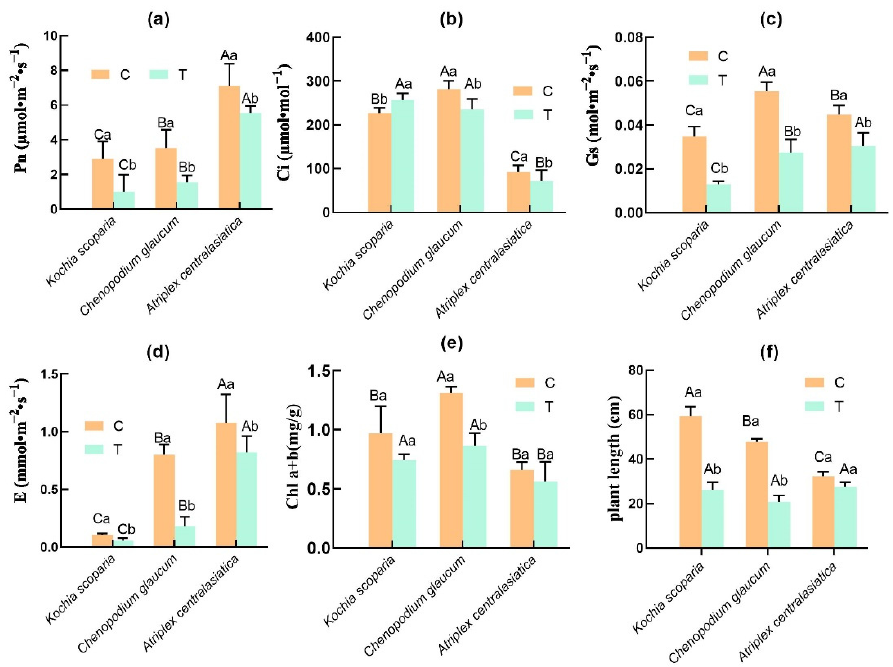
Figure 3. Changes in plant gas exchange parameters and plant height after tailings stress. Bars indicate mean ± SD ( n = 3). Different capital letters indicate significant differences between groups (between different plants) and different lowercase letters indicate significant differences within groups (control and treatment of the same plant) using the Tukey test ( p < 0.05). C represents the control group; T represents the experimental group. ( a ) Effects of heavy metals on the Pn of the three plants. ( b ) Effects of heavy metals on the Ci of the three plants. ( c ) Effects of heavy metals on the Gs of the three plants. ( d ) Effects of heavy metals on the E of the three plants. ( e ) Effects of heavy metals on the Chl a+b of the three plants. ( f ) Effects of heavy metals on the Plant length of the three plants.